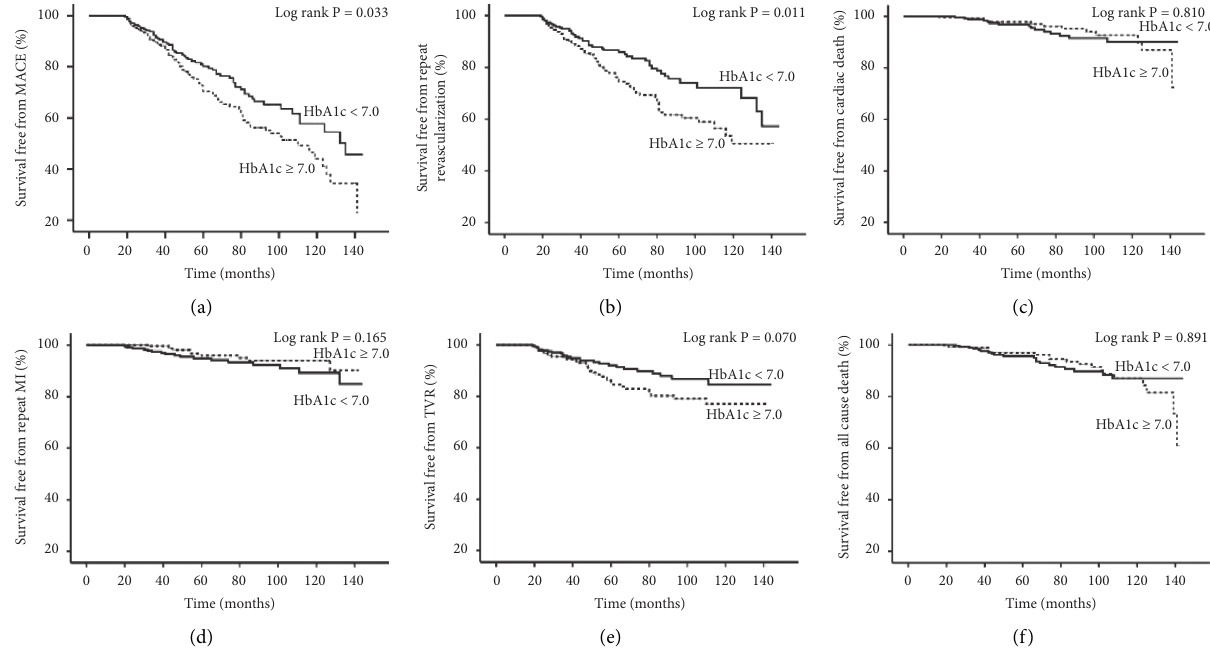
Figure 4: Kaplan–Meier cumulative event curves of MACE and secondary endpoints in the propensity score-matched population. HbA1c: glycosylated hemoglobin A; MACE: major adverse cardiovascular events, which was a composite of cardiac death, repeat revascularization, and repeat nonfatal MI; TVR: target vessel revascularization; MI: myocardial infarction. Table 4: Estimated Kaplan–Meier event rates in subgroups of propensity score-matched population. CTO-SR